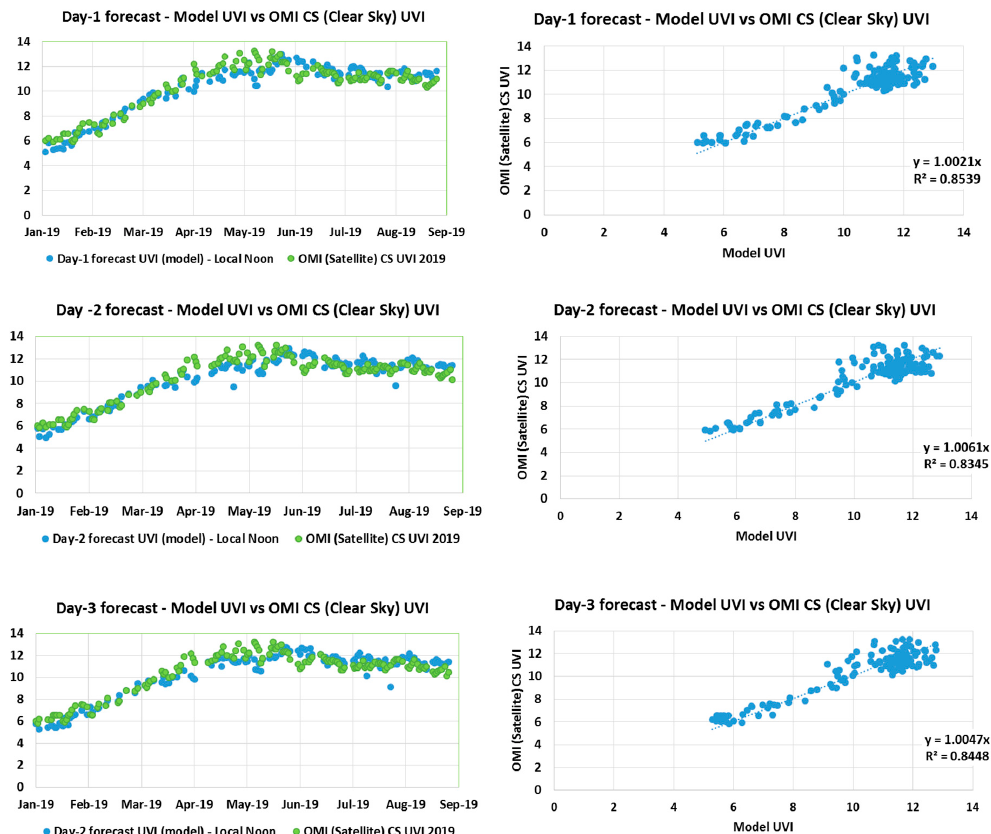
Figure 10. Comparison of the modeled UV Index forecast for daily (Day-1), 1 day (Day-2), and 2 days (Day-3) ahead with the actual NASA OMI Aura satellite derived UVI data on clear sky days from 1 January to 31 August 2019.